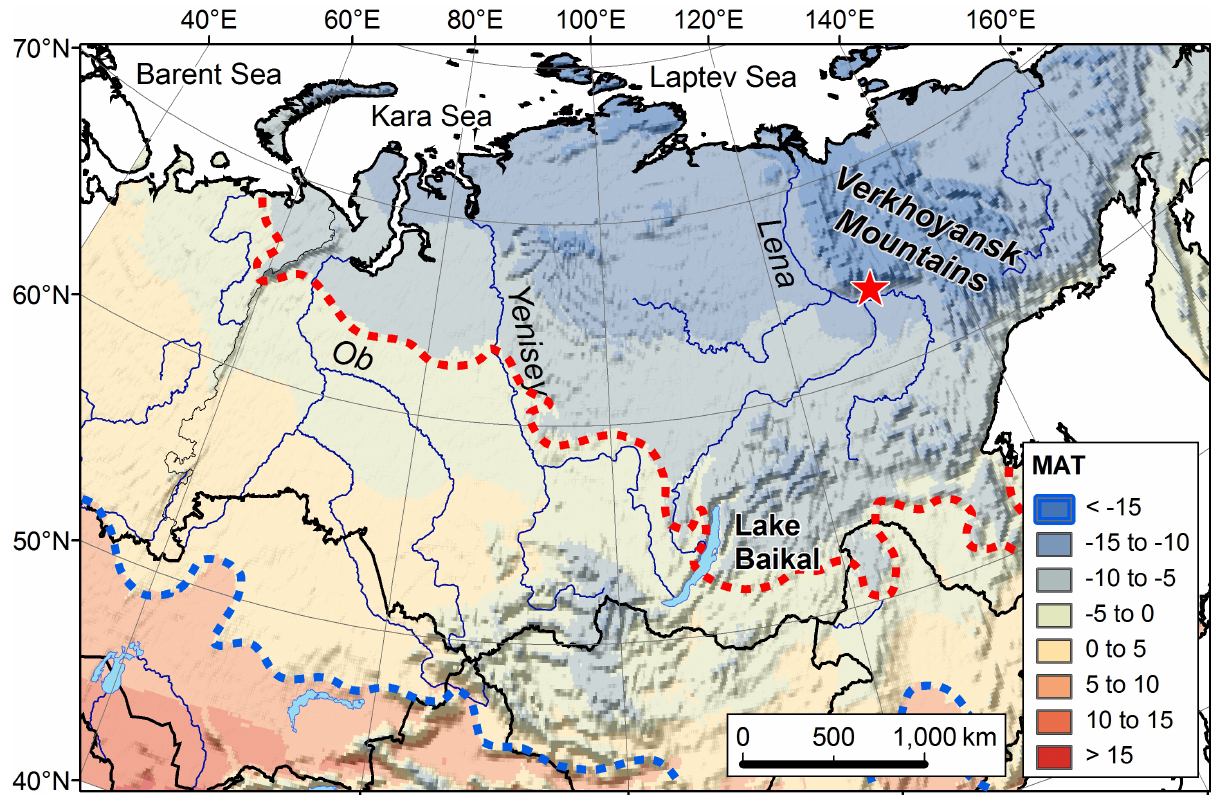
Fig. 1. Geographic setting of the research site and distribution of permafrost soils. The location of the Tumara Paleosol Sequence is indicated by the red star. Mean annual temperatures (MAT in ◦ C) (New et al., 2002) are draped over a hillshade model. The − 5 ◦ C isotherm (red dashed line) approximately marks the southward extent of continuous permafrost today (Tarnocai et al., 2009). Discontinuous permafrost exists at MAT < 0 ◦ C, and the +5 ◦ C isotherm (dashed blue line) indicates the approximate southward expansion of continuous permafrost during glacials assuming a 10 ◦ C temperature